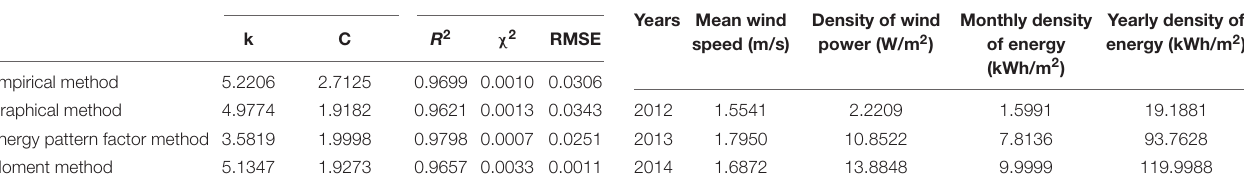
TABLE 7 | Density of wind